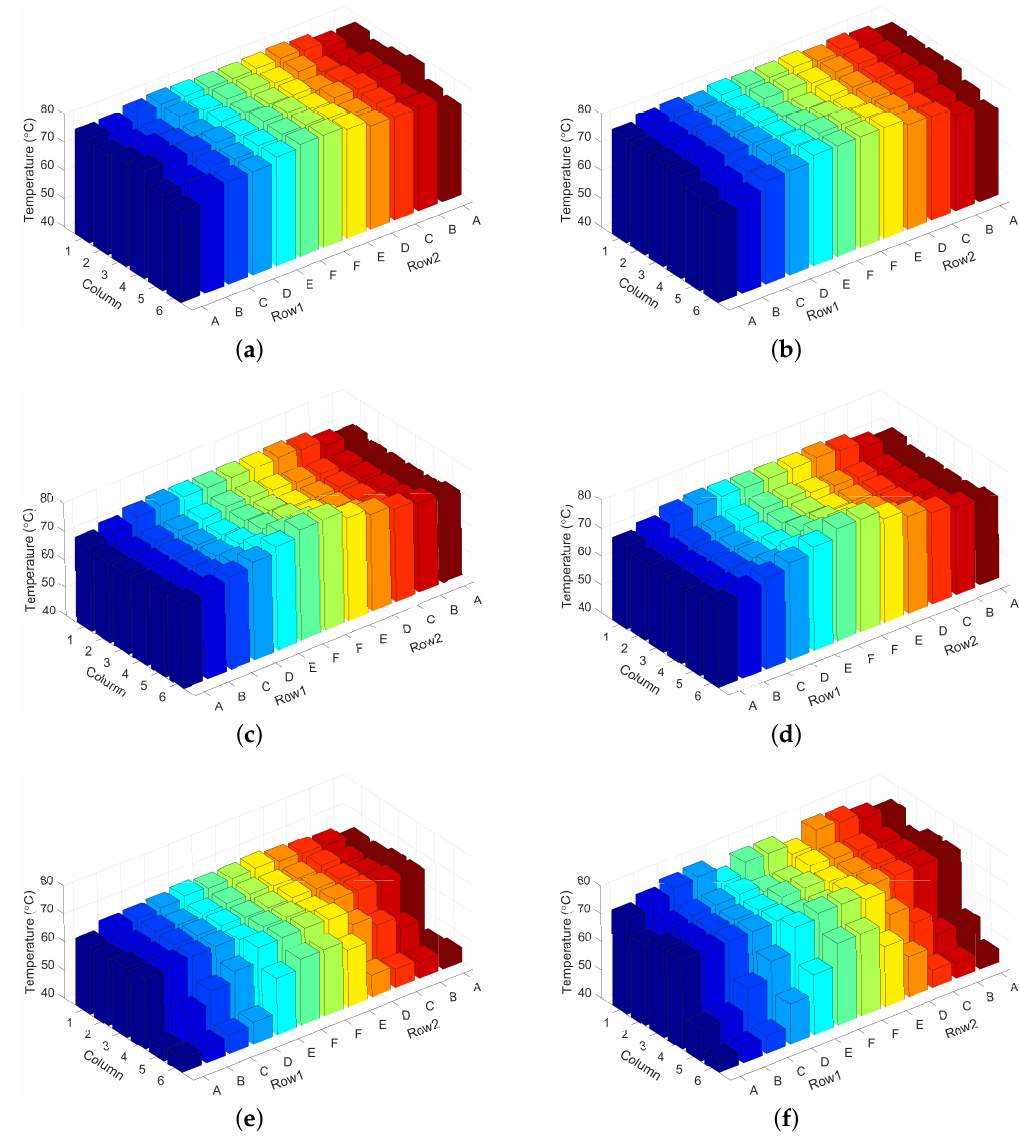
Figure 6. Chip temperature distributions achieved by different methods. ( a ) Chip temperature distribution of chip temperature-based workload allocation strategy (CTWA-MTP) with 60% utilization. ( b ) Chip temperature distribution of CTWA-MTP with 80% utilization. ( c ) Chip temperature distribution of modified uniform task (MUT) with 60% utilization. ( d ) Chip temperature distribution of MUT with 80% utilization. ( e ) Chip temperature distribution of MPIT-TA with 60% utilization. ( f ) Chip temperature distribution of minimizing the peak inlet temperature through task assignment (MPIT-TA) with 80%